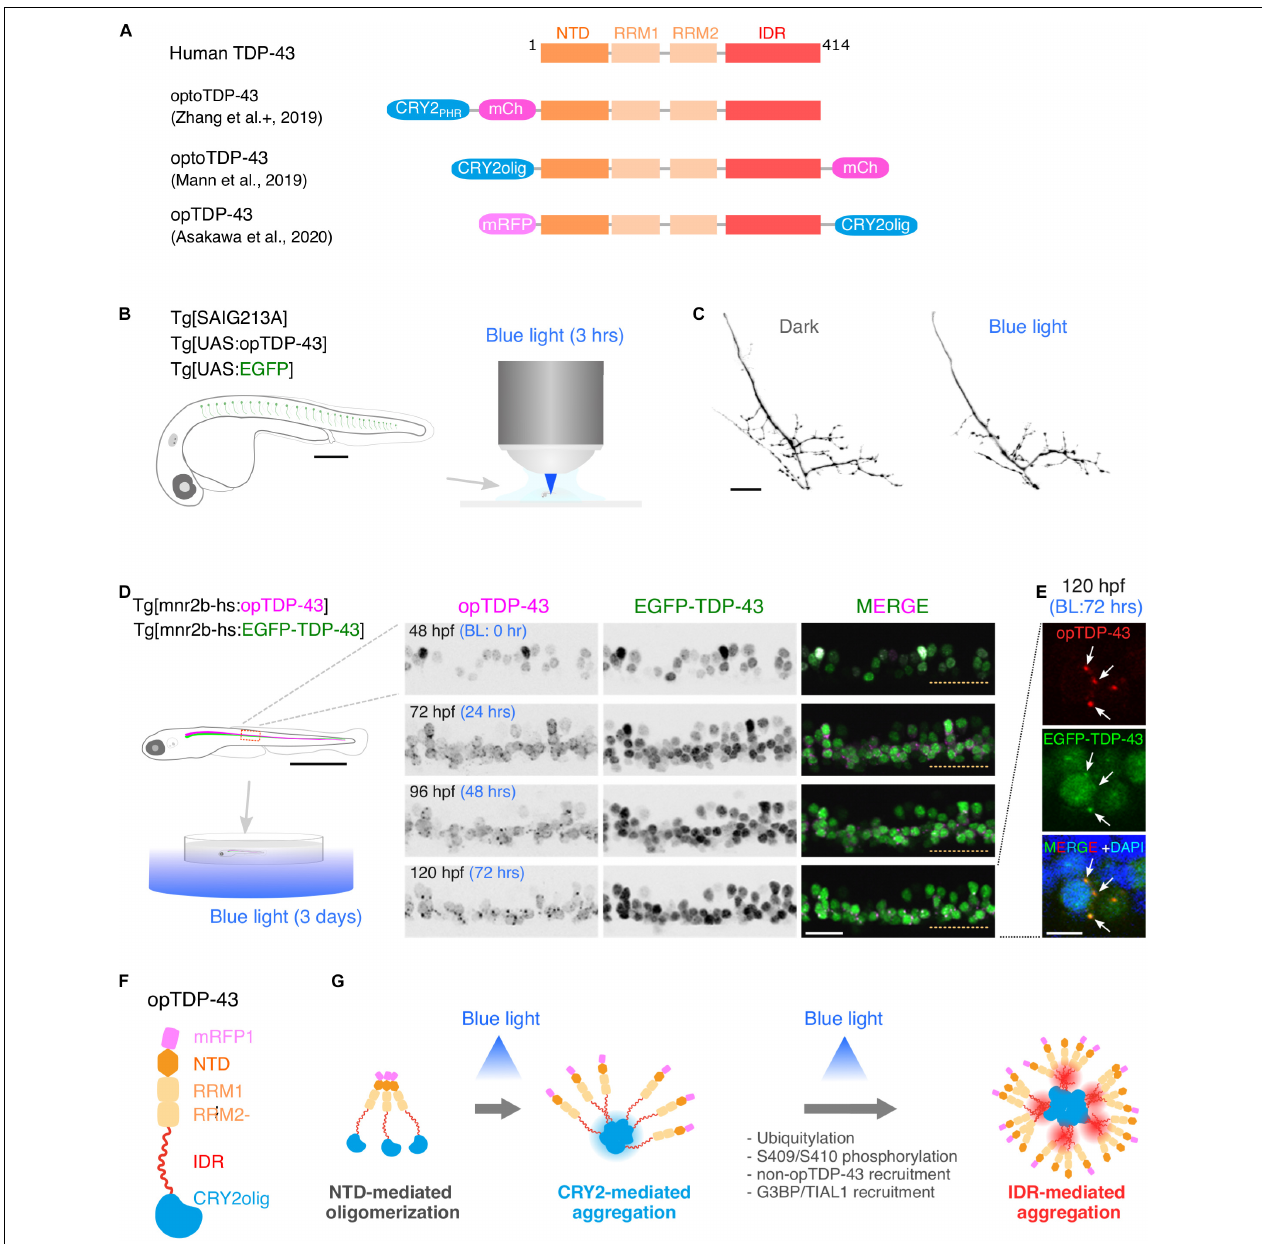
FIGURE 2 | Optogenetic induction of TDP-43 aggregates in in vivo spinal motor neurons. (A) Structures of optogenetic TDP-43. The human TDP-43 (top) consists of 414 amino acid residues subdivided into the N-terminal domain (NTD), 2 RNA recognition motifs (RRM1 and RRM2), and a C-terminus intrinsically disordered region (IDR). The optoTDP-43 (Mann et al., 2019; Zhang et al., 2019) and opTDP-43 (Asakawa et al., 2020) constructs carry the CRY2-modules at their N- and C-terminus, respectively. mCherry (237 aa), mRFP1 (225 aa), CRY2 PHR (498 aa), and CRY2olig (498 aa) not to scale with TDP-43. (B) An agarose-embedded zebrafish embryo expressing both EGFP and opTDP-43 in CaPs (Tg[SAIG213A] Tg[UAS:opTDP-43] Tg[UAS:EGFP] triple transgenic) is illuminated with a confocal blue laser light for 3 h, 28–31 h post-fertilization (hpf). (C) The total axonal length at 48 hpf was reduced in the CaP irradiated with the blue light (Blue light) compared to the CaP grown in the dark (Dark). The figure panels are adapted from Asakawa et al. (2020). (D) An unrestrained zebrafish larva expressing both opTDP-43 and non-optogenetic EGFP-TDP-43 was irradiated with blue LED light. The spinal motor column was scanned every 24 h for 3 days (from 48 to 120 hpf). The duration of the blue light illumination is indicated in blue letters. Horizontal dashed line demarcates the ventral limit of the spinal cord. The figure panels are adapted from the study by Asakawa et al. (2020). (E) Cytoplasmic opTDP-43 foci colocalize with non-optogenetic EGFP-TDP-43 (arrows) in the spinal motor neurons at 120 hpf in (D) . BL, Blue light. (F) Schematic drawing of opTDP-43 protein. (G) Blue light illumination drives CRY2olig-dependent opTDP-43 oligomerization and aggregation. A short-term illumination induces the oligomerization of opTDP-43, whereas a long-term illumination causes cytoplasmic aggregation of opTDP-43. Non-optogenetic TDP-43 is incorporated into the opTDP-43 aggregates [e.g., EGFP-TDP-43 in (E) ] possibly through IDR-mediated intermolecular interactions. Cytoplasmic opTDP-43 aggregates are partially positive for immunoreactivities against ubiquitin, phosphorylation at S409/S410, and classical stress granule components (G3BP and TIAL1) (Asakawa et al., 2020). The bars indicate 250 µ m (B) , 20 µ m (C) , 1 mm ( D , left), 20 µ m ( D , panels), and 5 µ m (E) .